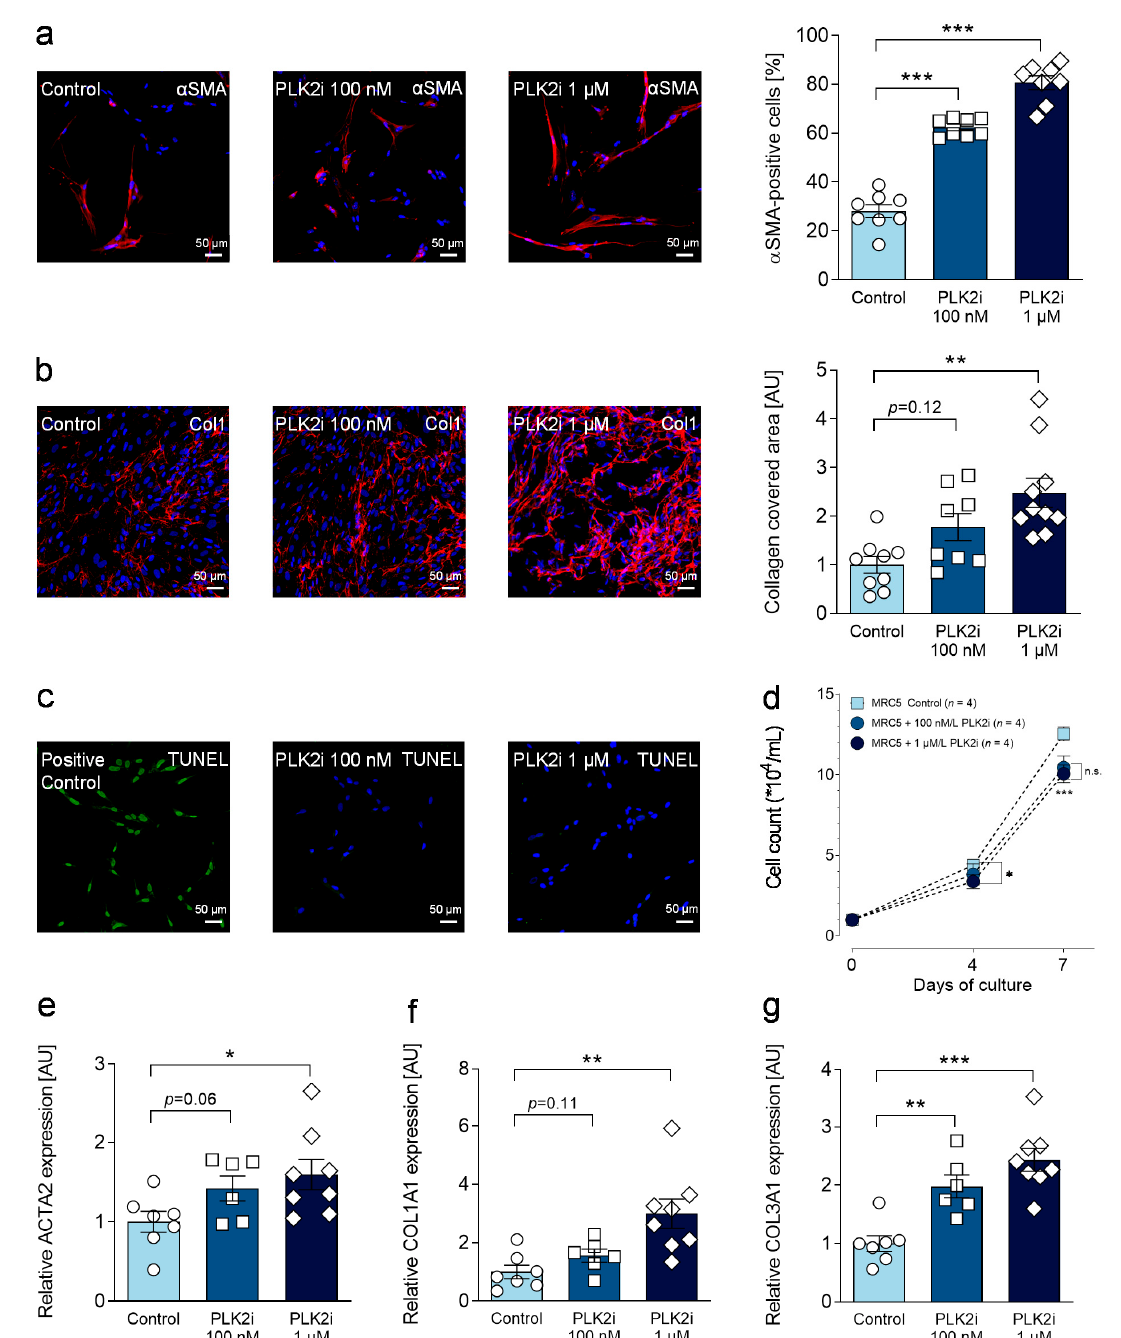
Figure 4. Effects of pharmacological PLK2 inhibition in human pulmonary MRC5 fibroblasts. ( a ) Quantification and representative immunofluorescence images of α SMA myofilaments in MRC5 fibroblasts under control conditions and in the presence of 100 nM or 1 µ M specific PLK2 inhibitor (TC-S 7005) ( n = 8 per group). The nuclei were stained with DAPI (blue). The scale bars equal 50 µm. ( b ) Quantification and representative immunofluorescence images of extracellular collagen 1 (Col1) deposition in MRC5 fibroblasts under control conditions and in the presence of 100 nM or 1 µM specific PLK2 inhibitor (TC-S 7005) (8 ≤ n ≤ 10). ( c ) Representative images of TUNEL staining to detect apoptosis. ( d ) Proliferation curves of MRC5 fibroblasts under control conditions and in the presence of 100 nM or 1 µM specific PLK2 inhibitor (TC-S 7005) ( n = 4 per group). Cells were counted after 3 and 6 days. ( e – g ) Quantification of ACTA2, COL1A1 and COL3A1 gene expression determined by RT qPCR in MRC5 fibroblasts under control conditions and in the presence of 100 nM or 1 µM specific PLK2 inhibitor (TC-S 7005) (6 ≤ n ≤ 8). * p < 0.05. ** p < 0.01. *** p < 0.001. n.s. = not significant.